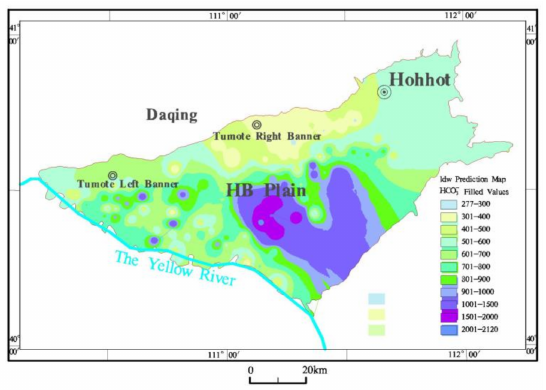
Figure 7. Contour map of HB Plain HCO 3 −